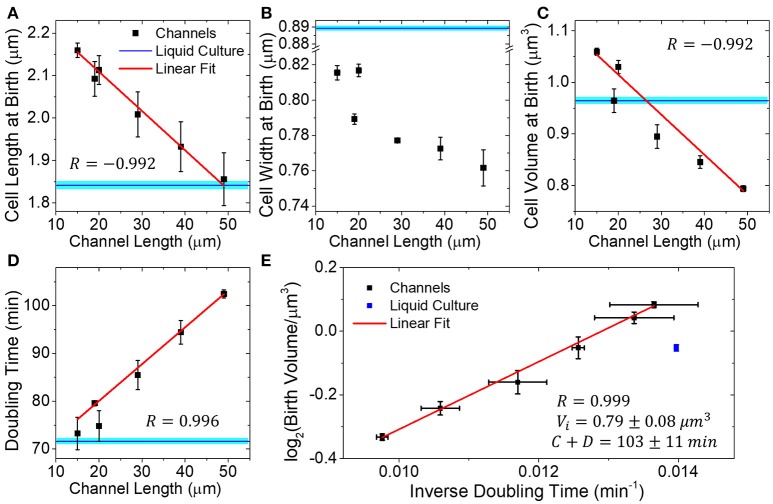
Dimensions and doubling times of mother cells in channels of different lengths. (A–D) Mother cell length, width, and volume at birth, and doubling time as a function of channel length. All channels are 0.9 μm wide. Each data point is an average of three independent measurements. In each measurement, more than 300 cell births have been analyzed. Error bars are s.e.m. of the three independent measurements. Blue horizontal lines correspond to measurements of these quantities from liquid culture cells. Solid lines are linear fits to data. (E) Logarithm of birth volume, Vb, as a function of inverse doubling time, Td-1, and it fits to the universal growth law, Vb=(12)Vi•2C+DTd.